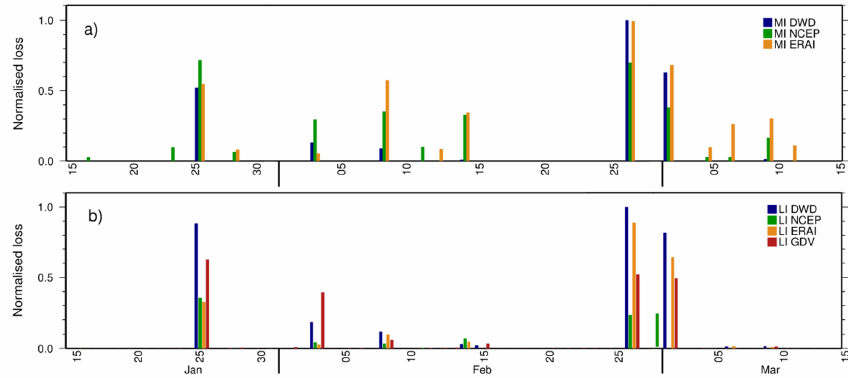
Figure 2. Time series of 3-day accumulated losses between 15 January and 15 March 1990. The values are normalised by the maximum accumulated loss of the period 1981/82 to 2010/11 for each data set. (a) Comparison between MI derived DWD gust observations (blue), MI estimates based on NCEP (green) as well as MI obtained from ERAI (orange); (b) same as (a) but for LI and additionally compared to simulated insurance data (GDV, red). Unlike MI, LI is population